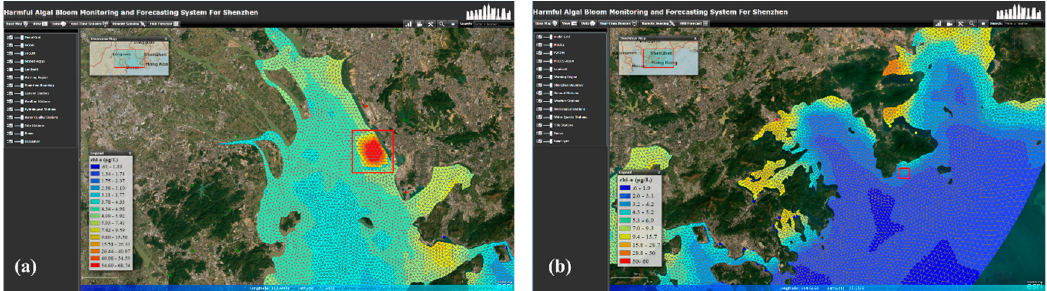
Figure 14. Forecast results of two real HAB events: ( a ) A HAB event occurred in the Peral River Estuary during 1–10 November, 2018 and ( b ) a HAB event occurred in the Mirs bay during 5–8 March, 2018. The red rectangles in the figures indicate the area affected by HAB events.